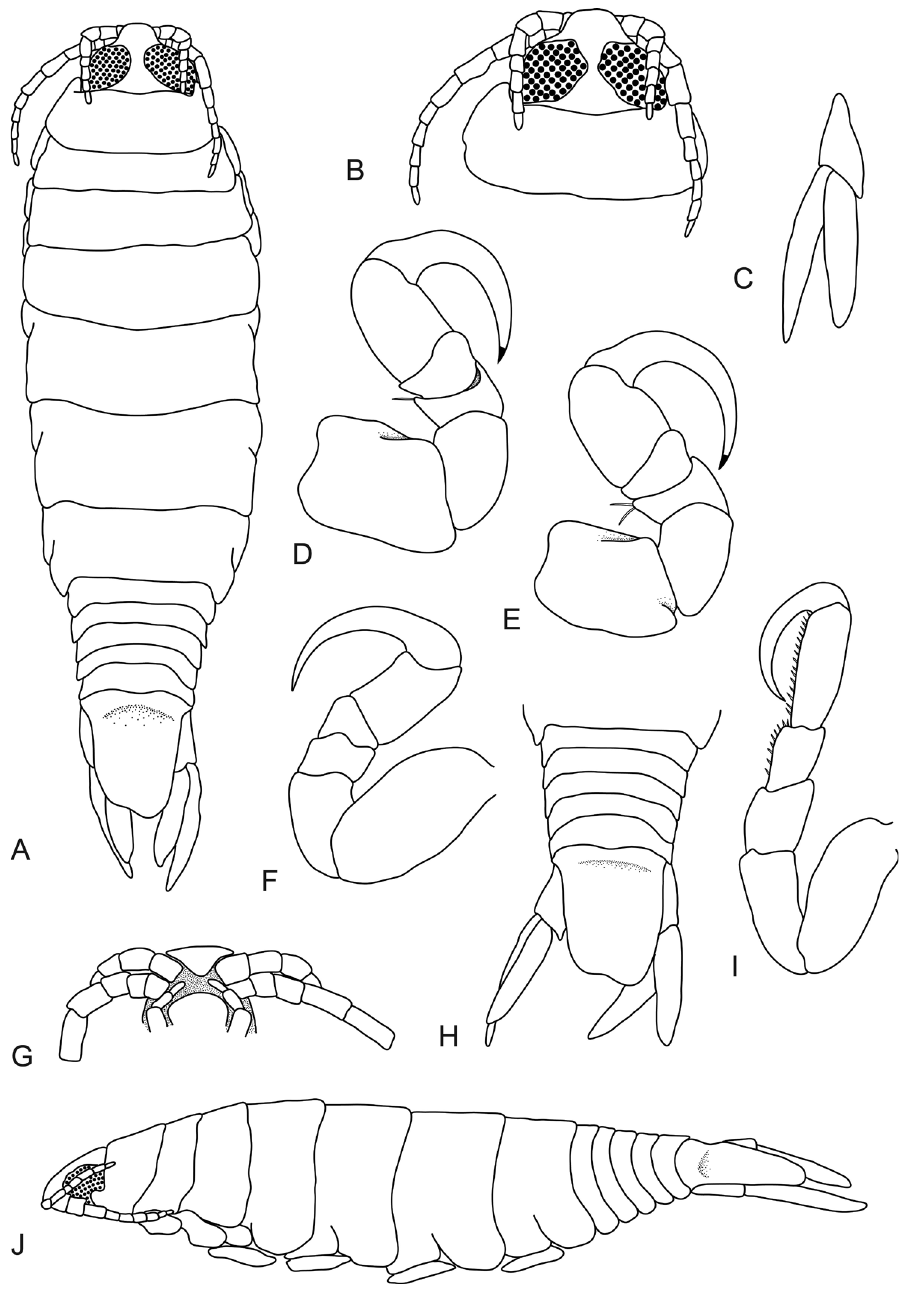
Figure 4. Pleopodias nielbrucei sp. n. (SAMC A088881), female holotype (30 mm). A dorsal view B dorsal view of pereonite 1 and cephalon C uropod D pereopod 1 E pereopod 2 F pereopod 6 G ventral view of cephalon H dorsal view of pleon and pleotelson I pereopod 7 J lateral